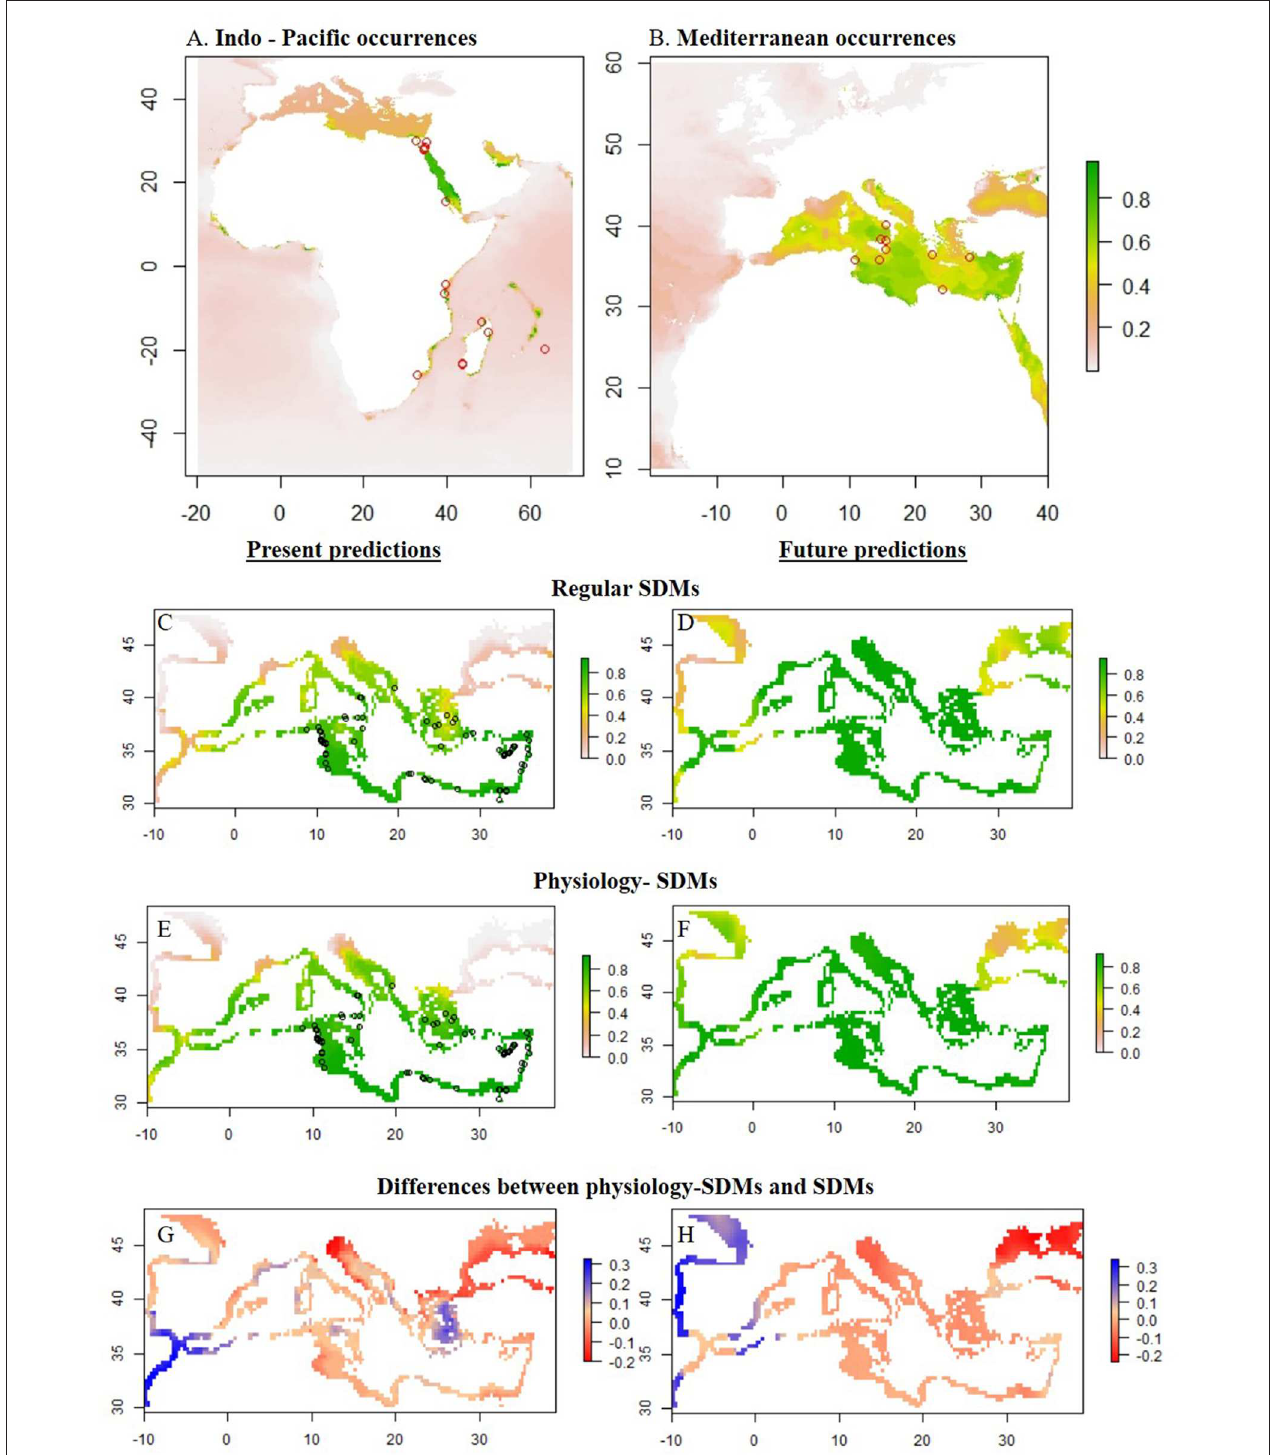
FIGURE 8 | Halophila stipulacea distribution models based on MaxEnt showing relative habitat suitability based solely on (A) native Indo-Pacific and (B) invasive Mediterranean occurrences. Predicted habitat suitability of H. stipulacea in the Mediterranean Sea under current environmental conditions (left; C,E,G ) and forecasted under future (2100) environment (right; D,F,H ). Models include either regular SDMs (C,D) or combined physiology-SDMs (E,F) . Lower panels (G,H) show the difference between the physiology-SDMs (E,F) and the regular SDMs (C,D) . Blue colors (G,H) indicate regions where physiology-SDMs predict high occurrence probability than regular SDMs. Figures adapted from Gamliel et al.